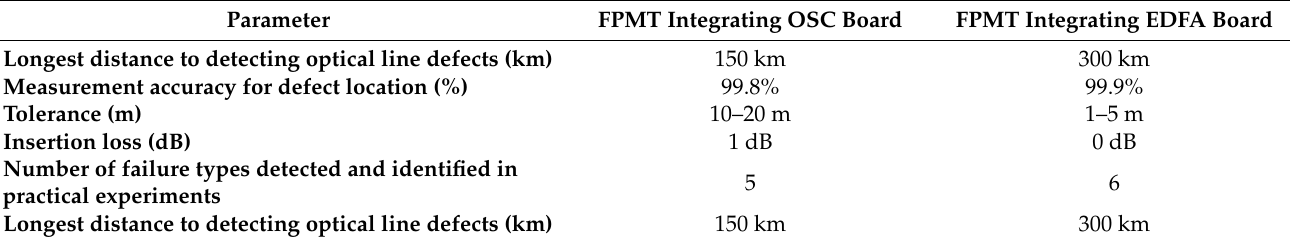
Table 11. Comparison between FPMT techniques integrating with OSC or EDFA board.